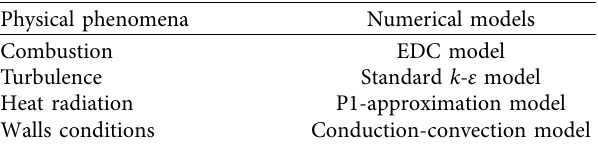
Table 3: Numerical models of main physical phenomena involved in compartment